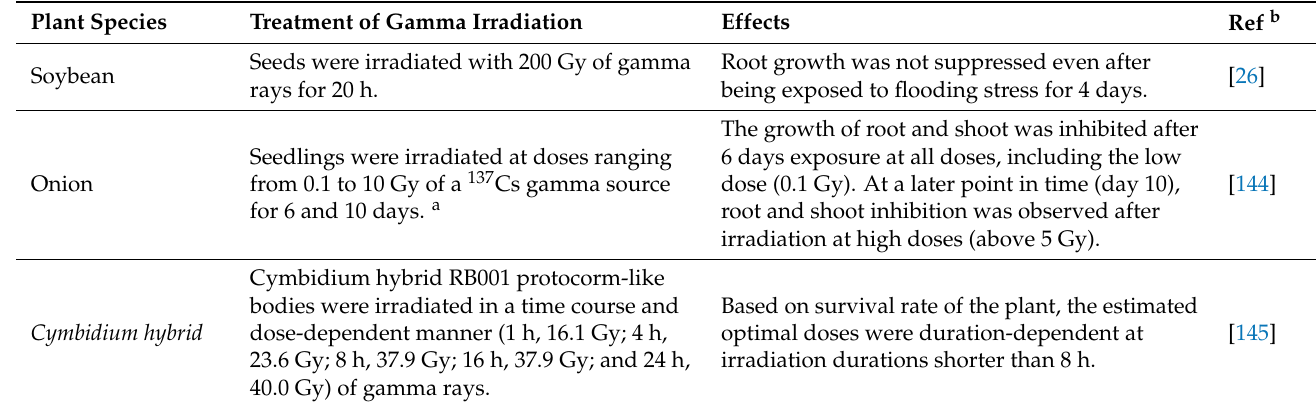
Table 4. Morphophysiological effects of gamma irradiation on